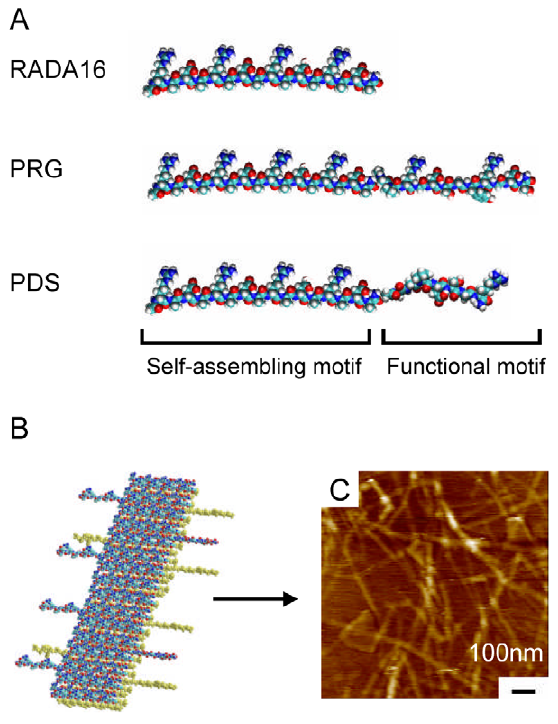
Figure 1. Molecular model of designer peptides and nanofiber. A) Molecular models of designer peptides RADA16, PRG and PDS. B) Molecular model of self-assembling peptide nanofibers formation with PRG peptide, representing a beta-sheet structure. Note the sequences PRG extending out from the nanofiber. C) Typical AFM morphology of a self-assembling peptide nanofiber scaffold PRG mixed with RADA16. (Photograph by Akihiro Horii).